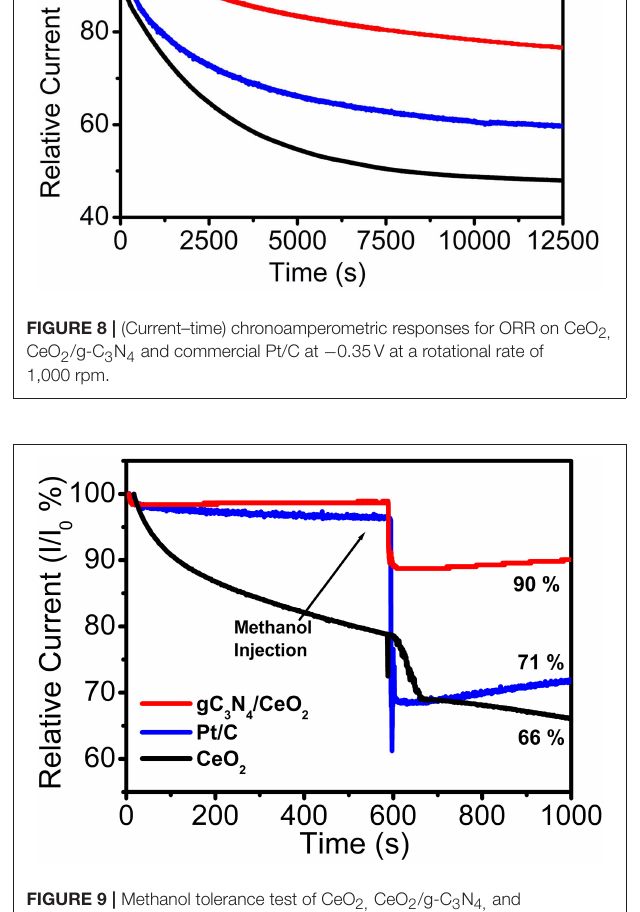
FIGURE 9 | Methanol tolerance test of CeO 2, CeO 2 /g-C 3 N 4, and commercial Pt/C.